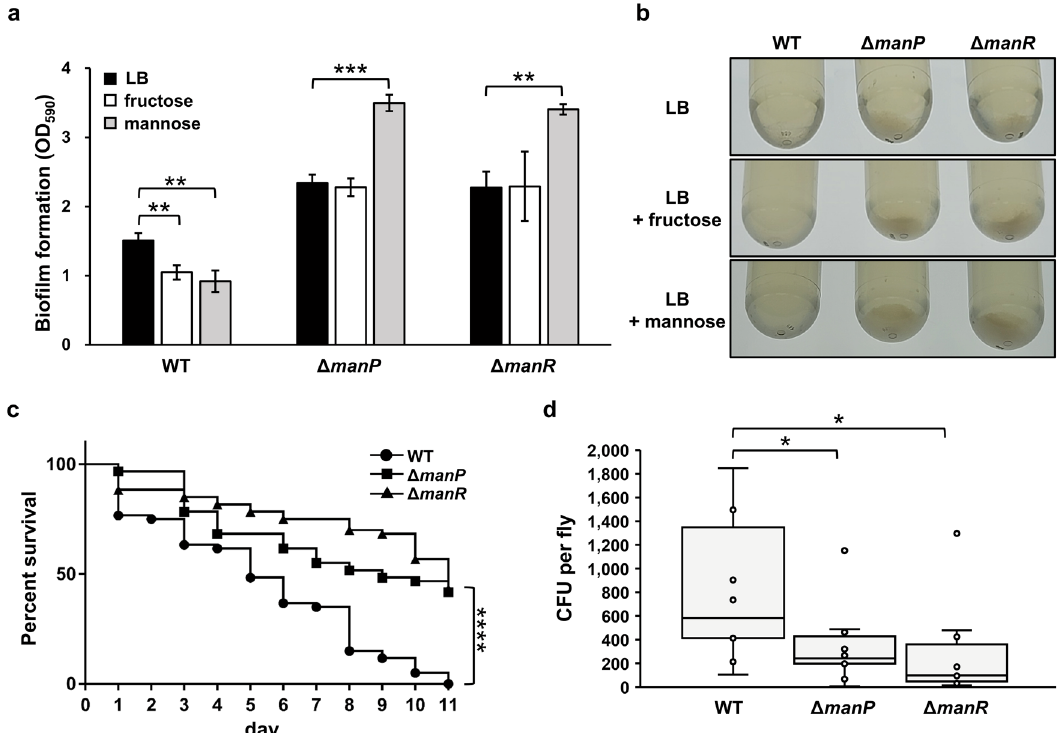
Fig. 6 V. cholerae ManR regulates bio fi lm formation, intestinal colonization, and virulence in Drosophila . a Bio fi lm formation of WT, Δ manP, and Δ manR V. cholerae strains measured in LB supplemented with fructose or mannose using the crystal violet staining method following the static growth of V. cholerae cells for 24 h. The stained bio fi lm was determined at 590 nm. The means and standard deviations of the three independent measurements are shown. b Macroscopic analysis of autoaggregation of WT, Δ manP, and Δ manR strains. The indicated strains statically cultured in LB supplemented with fructose or mannose. After 24 h, photographs of the bottom of culture tube were taken. c Survival of fl ies was assessed by infection assays using WT, Δ manP, and Δ manR . Flies were fed a solution containing approximately 1.6 × 10 10 cells ml − 1 of the indicated V. cholerae strains. Flies were transferred into new feeding vial and fed a new solution every day, and dead fl ies were counted. Survival curves were plotted and analyzed by the log-rank test using GraphPad PRISM version 6 software (**** P < 0.0001). d Intestinal colonization of V. cholerae in fl ies was assessed for a short infection period. Flies were fed a solution containing approximately 1.6 × 10 10 cells ml − 1 of the indicated V. cholerae strains for 4 h and then fed sterile water for another 3 h for clearing processes. Each fl y gut was homogenized in sterile water and spread on a selective medium for V. cholerae and colony-forming units (CFUs) were measured. The means and standard deviations of the ten independent measurements are shown. Statistical signi fi cance was determined using the Student ’ s t -test (* P < 0.05, ** P < 0.005, *** P < 0.0005, and **** P <